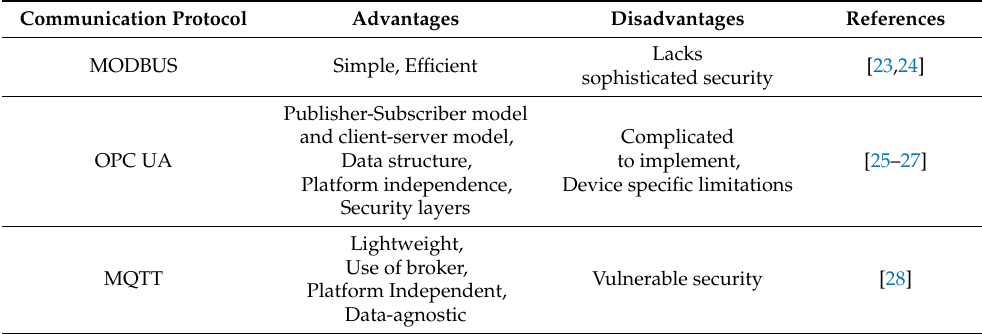
Table 1. Characteristic of machine-to-machine communication protocols in the automation process. Communication